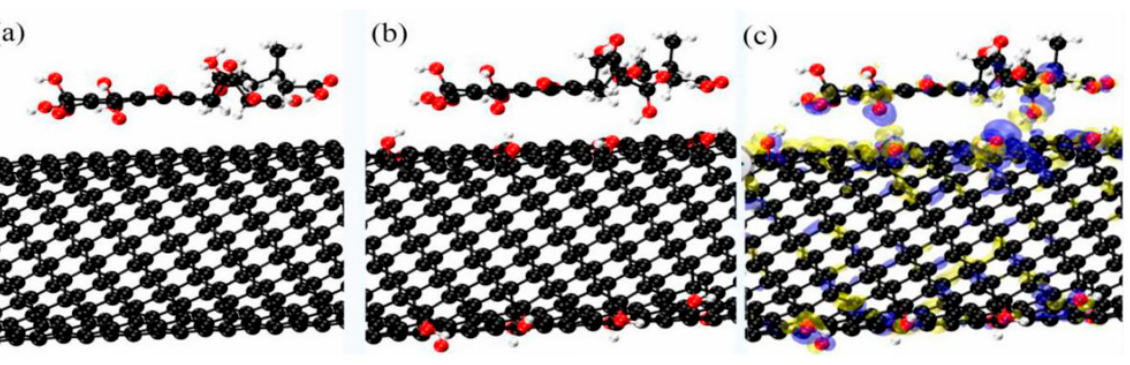
Figure 12. DFT for HA adsorbed on MWNT ( a ) and HMWNT facets ( b ), and the charge difference between the HA molecules and HMWNTs ( c ). The dark gray, light gray and red balls represent carbon, hydrogen and oxygen atoms, respectively.